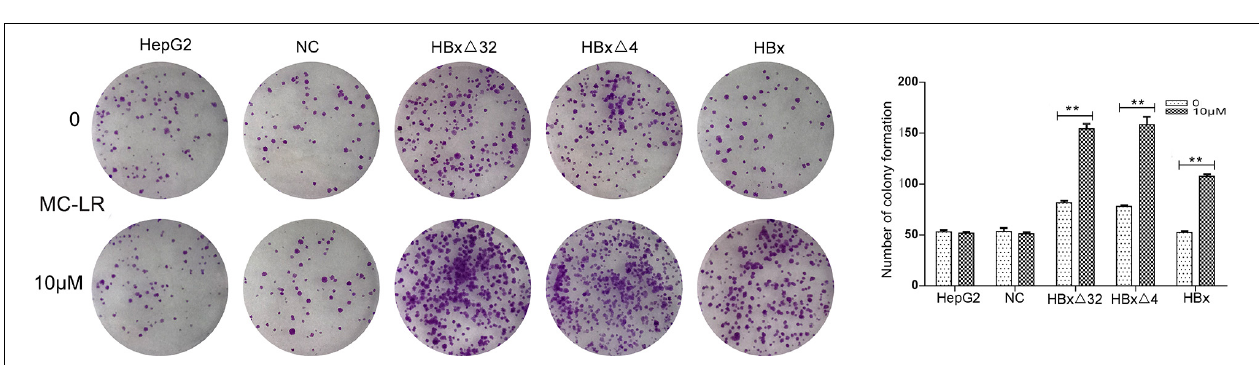
FIGURE 5 | Effect of MC-LR and ctHBx on the colony formation capabilities of HepG2 cells. The colony forming ability between HBx (cid:49) 32, HBx (cid:49) 4, and HBx cells incubated with 10 µ M MC-LR were compared, it was found that the colony forming ability of these three groups were statistically difference ( F = 26.948, P = 0.001), HBx (cid:49) 32 and HBx (cid:49) 4 groups were stronger than HBx group (HBx (cid:49) 32 vs. HBx P = 0.001; HBx (cid:49) 4 vs. HBx P = 0.001). Bar graphs indicate means ± standard deviation from three independent experiments. ** P < 0.01 vs. 0 µ M MC-LR.